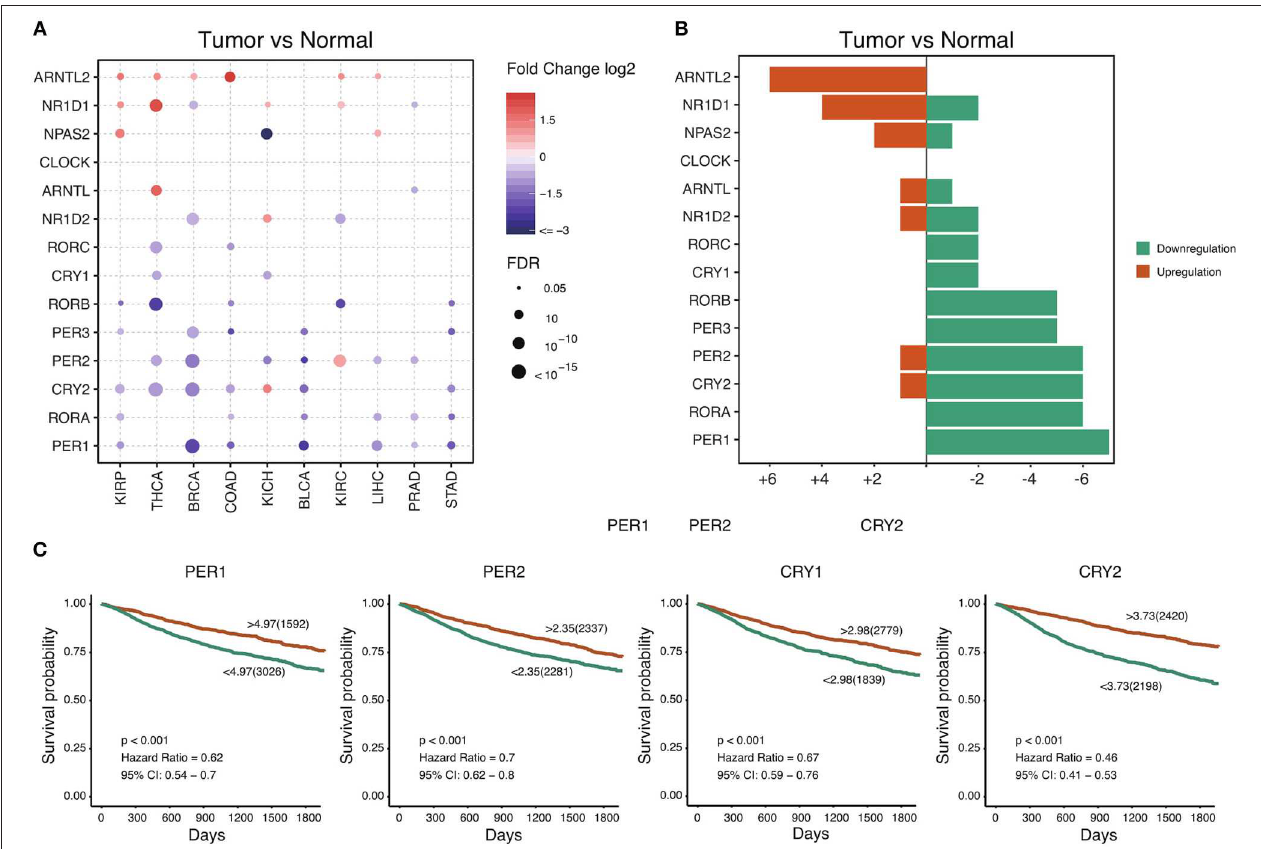
FIGURE 1 | Core circadian clock genes are dysregulated in cancers. (A) The mRNA difference between normal samples and tumor samples. Only significant differential expressed genes were shown. (B) The summary of mRNA alteration of core circadian clock genes. (C) Dysfunction of circadian clock contributes to poor prognosis in